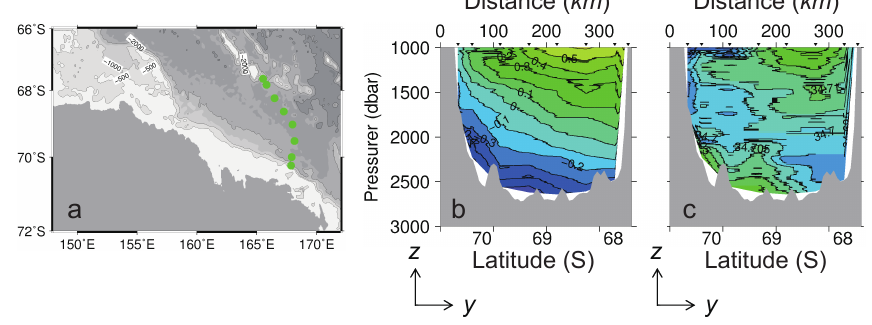
Fig. 8. Thickness and width (cross shore) of the RSBW from occupations in the 1990s. (a) Location of stations, (b) vertical cross section of potential temperature, (c) vertical cross section of salinity. y is cross shore coordinate (offshore positive), and z is vertical axis (upward positive). Thickness and width of cold and saline the RSBW are approximately 200m and 200km, respectively.